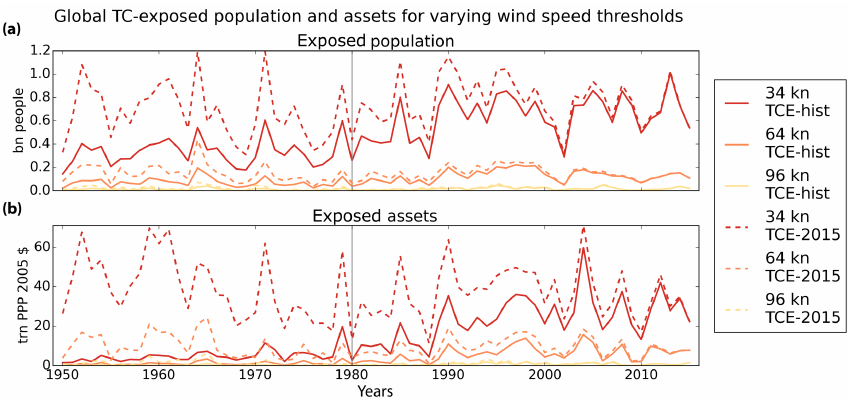
Figure 3. Annual global TC exposure for different thresholds of wind speed (34kn, red; 64kn, orange; 96kn, yellow). Dashed lines: estimates based on fixed 2015 patterns of population and assets (TCE-2015); solid lines: estimates based on the historical evolution of population and assets patterns